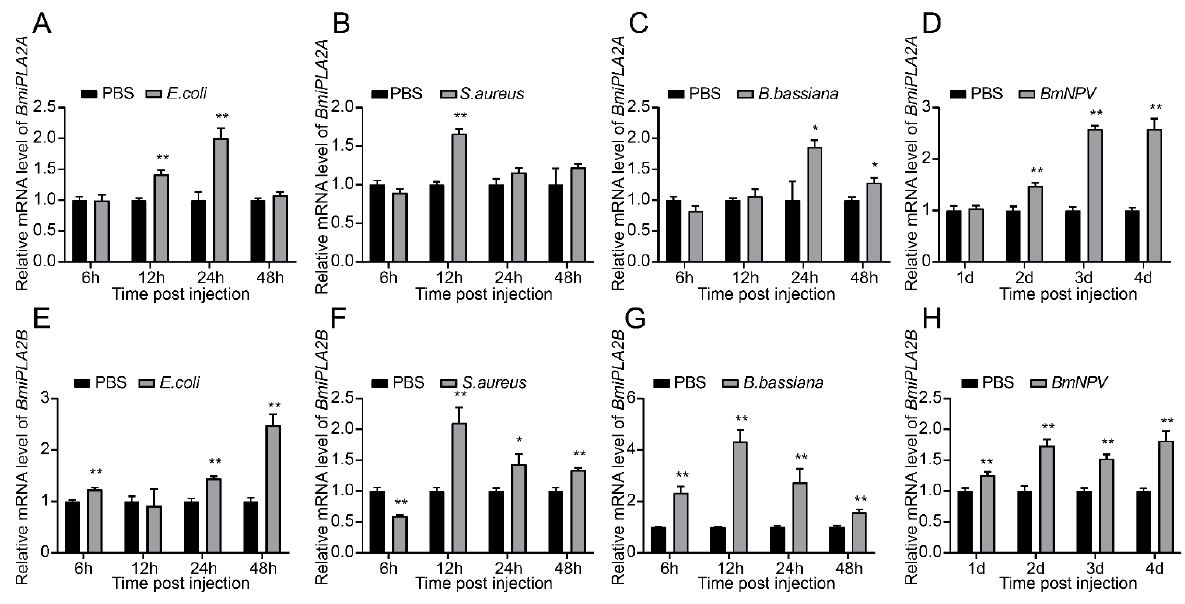
Figure 8. Temporal mRNA expression of BmiPLA2A and BmiPLA2B in hemocytes of immune challenged silkworm larvae. The expression profiles at 6, 12, 24, and 48 h were analyzed after treatment with ( A , E ) Gram-negative bacteria Escherichia coli ( E. coli ), ( B , F ) Gram-positive bacteria Staphylococcus aureus ( S. aureus ), ( C , G ) fungus Beauveria bassiana ( B. bassiana ), and ( D , H ) virus Bombyx mori nucleopolyhedrovirus ( BmNPV ). The asterisks indicate the significance was statistically significant or extremely significant (* p < 0.05, ** p < 0.01 and *** p < 0.001).